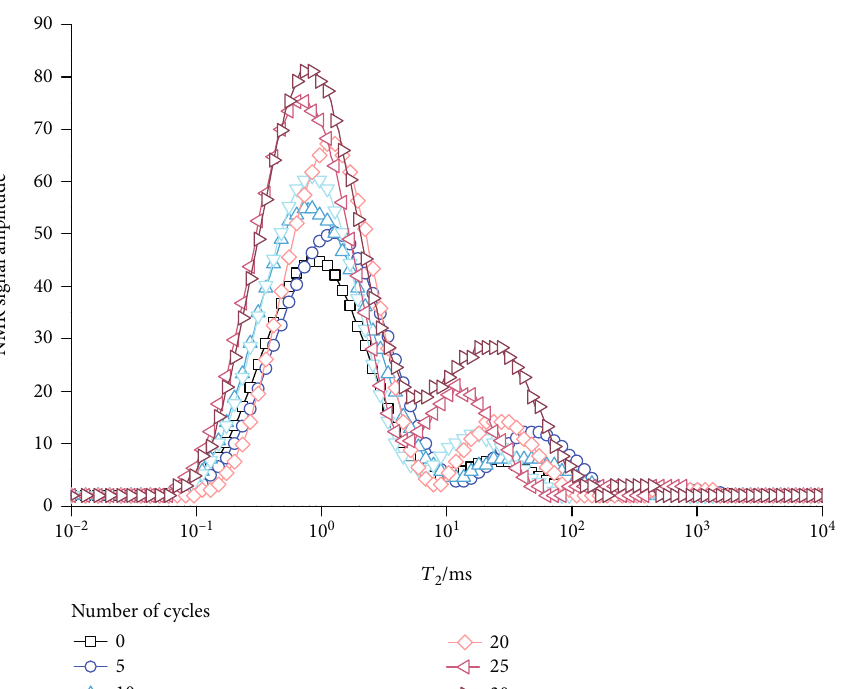
Figure 4: The variation of mass loss.